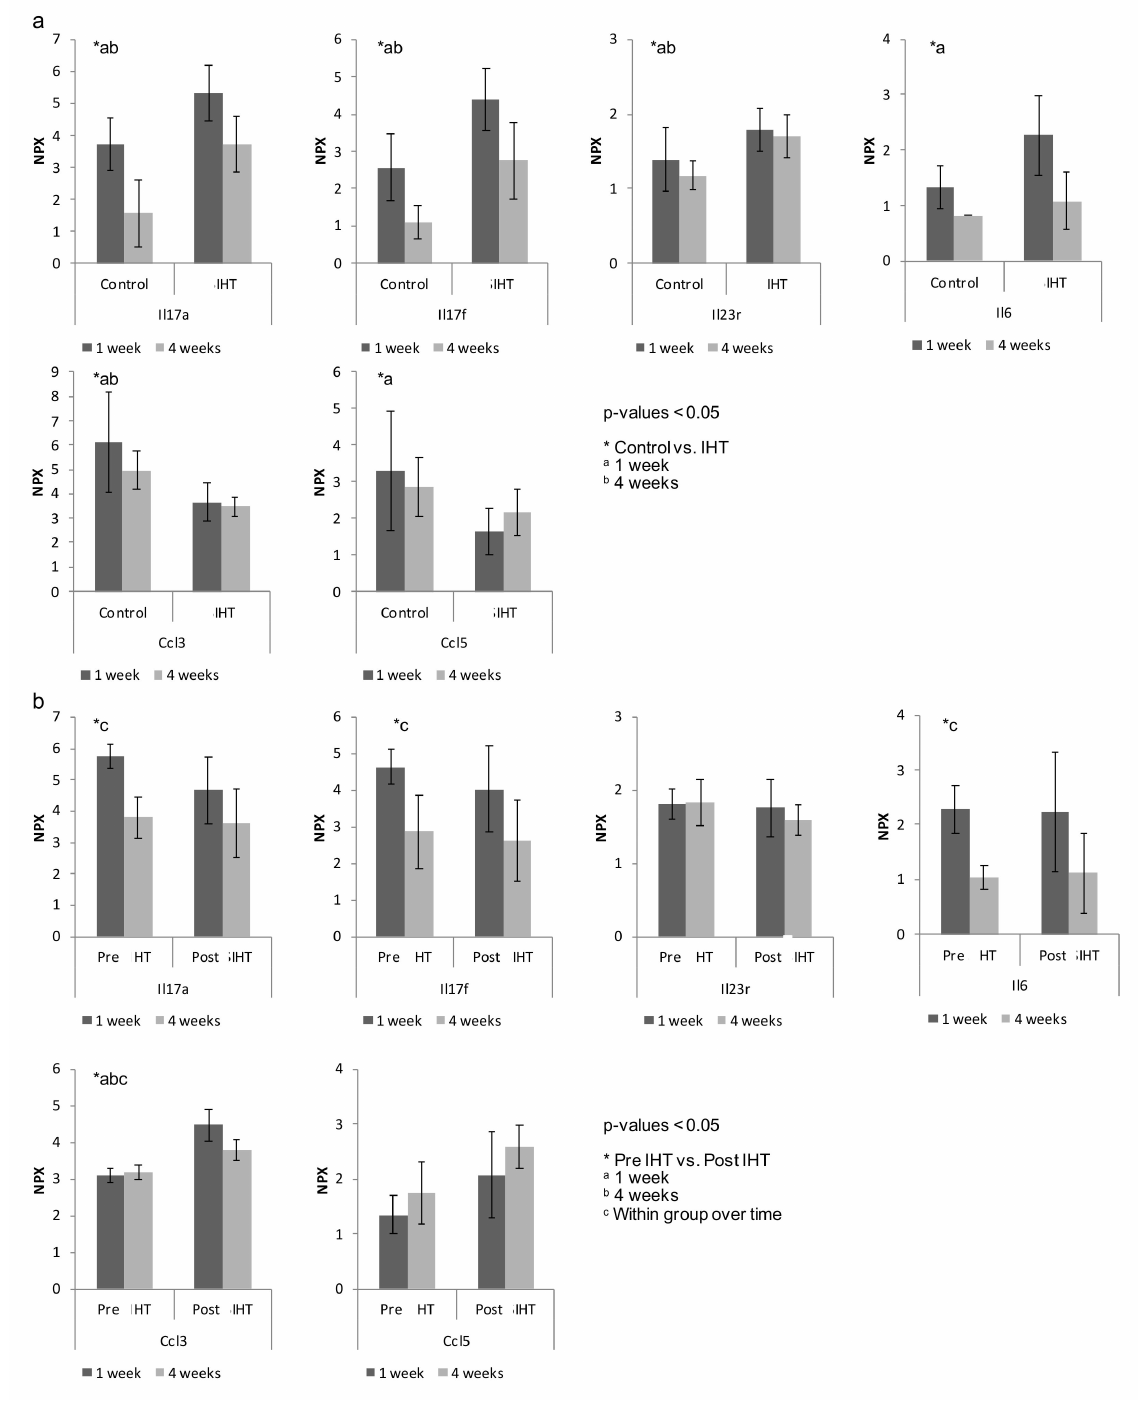
Figure 8. Intermittent Hypoxic Therapy (IHT) induces systemic osteoimmunological expression compared with control. Log2-transformed arbitrary units normalized protein expression (NPX) of selected proteins after 1 and 4 weeks. The cytokines (ILs) had the highest response within IHT after 1 week, while the chemotactic cytokines (Ccls) were downregulated in IHT at both time points. Vertical axes represent NPX values. Horizontal axes represent treatment groups visualized over time. n = 12, biological independent samples. Horizontal axes represent treatment groups visualized over time. n = 6, biological independent samples. Statistical analysis was performed using one-way ANOVA or the Kruskal–Wallis rank test. Data are presented as unadjusted NPX data, ( a ) * control compared with IHT or ( b ) * pre IHT compared with post IHT. a 1 week, b 4 weeks, and c within IHT over time. p -values < 0.05 were considered statistically